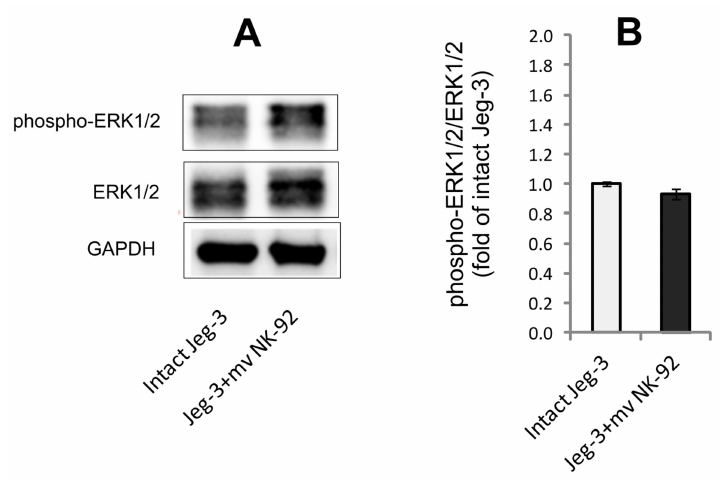
Figure 7. Effect of NK-92 cell MVs on ERK/2 phosphorylation in lysates of JEG-3 cells. ( A ) Im- munoblot demonstrates content of ERK1/2 in intact JEG-3 cells and after their interaction with NK-92 cell MVs; ( B ) ratio of phospho-ERK1/2 and total ERK1/2 in the studied samples (n =